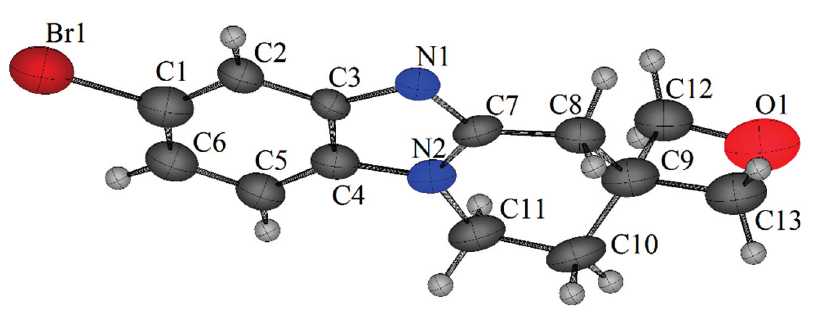
Figure 3. X-ray crystal structure of 7 ʹ -bromo-1 ʹ ,2 ʹ -dihydro-4 ʹ H -spiro[oxetane-3,3 ʹ